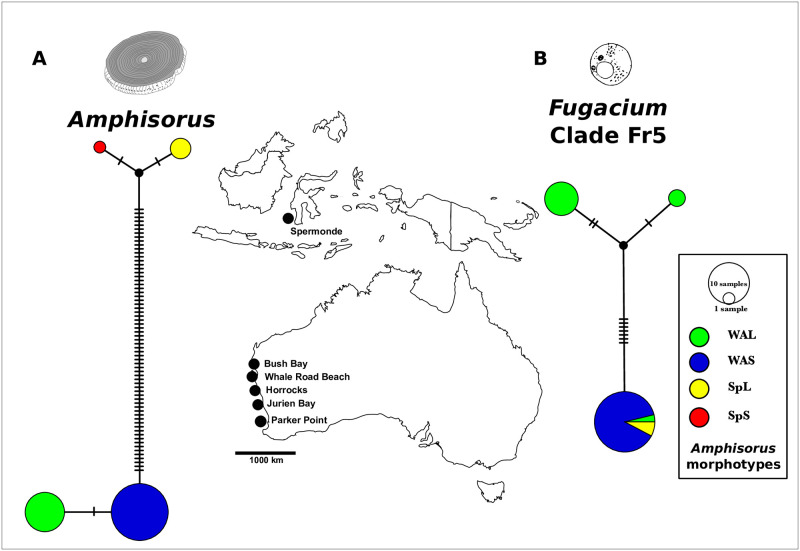
Map showing the sampling locations in Australia and Indonesia, and median-joining networks showing the four Amphisorus genotypes (based on a 4,307bp fragment spanning the partial 18S rRNA, 5.8S rRNA, and partial 28S rRNA), and three Fugacium Fr5 genotypes (based on a 606bp 28S rRNA fragment).Each circle in the network represents a distinct genotype. Colours indicate the morphotype of analysed Amphisorus specimens. Each black bar indicates one substitution. Circle size corresponds to the number of specimens.